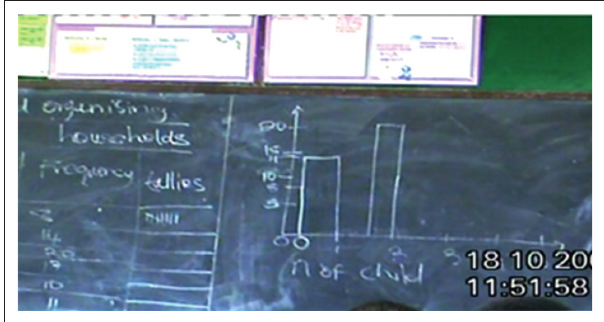
FIGURE 8: Graph showing the number of children in different